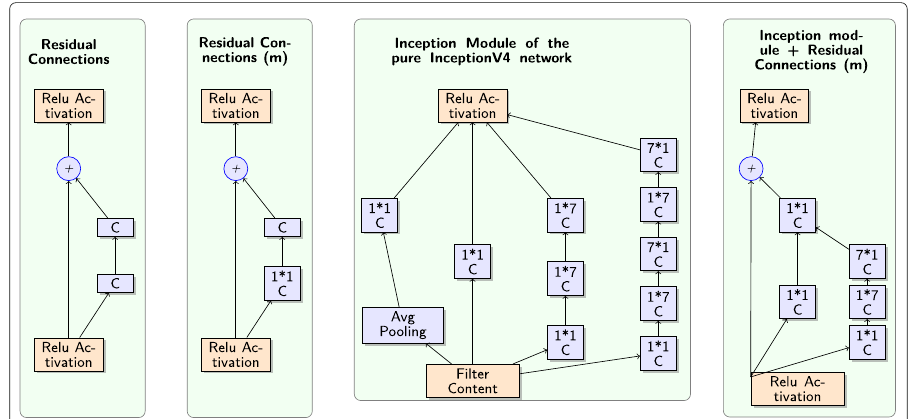
Fig. 3 From left to right in order are original residual connections [70], modified residual connections used in [36], the schema for 17 × 17 grid of the pure InceptionV4 network, and the schema for 17 × 17 grid (Inception-ResNet-B) module of Inception-ResNet-v1